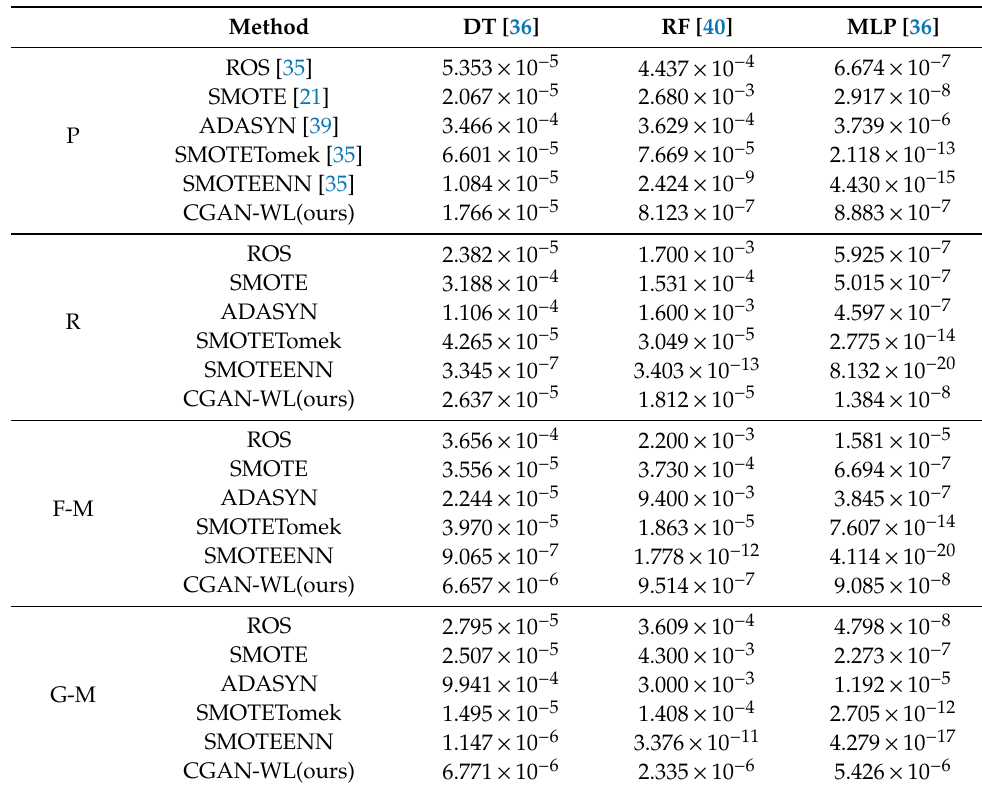
Table 3. Summary of Welch’s T-test with significance level at 0.05 using three